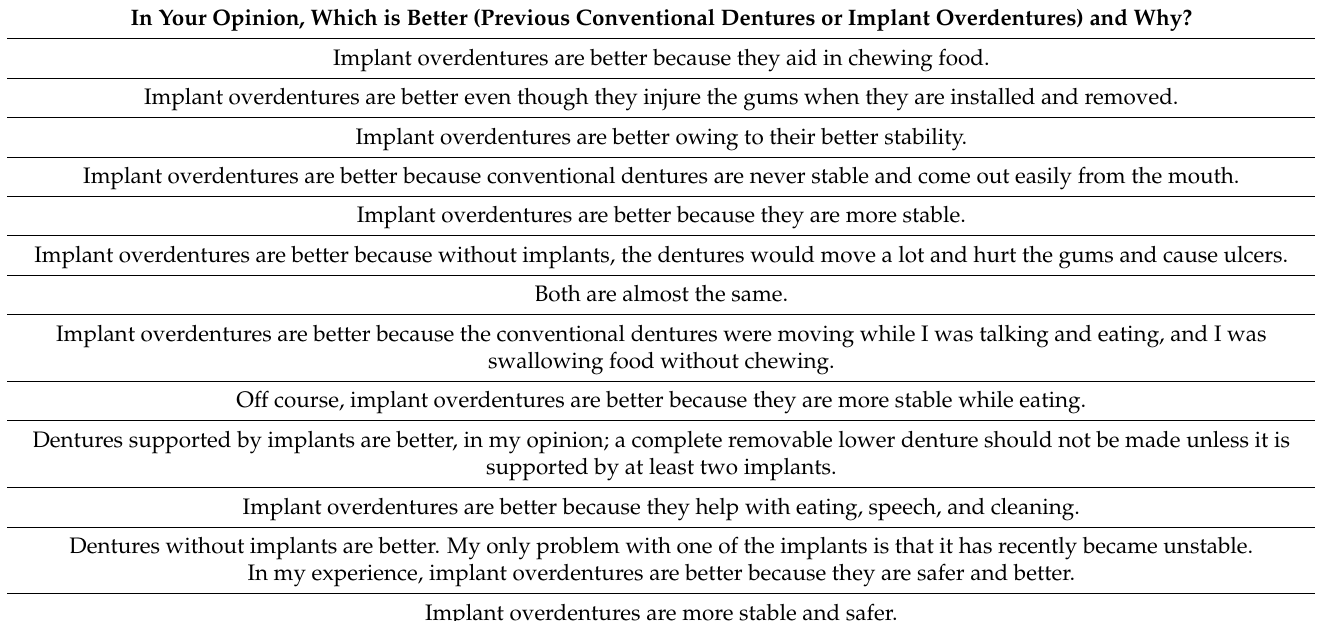
Table 4. Open-ended responses of subjects regarding their preference for